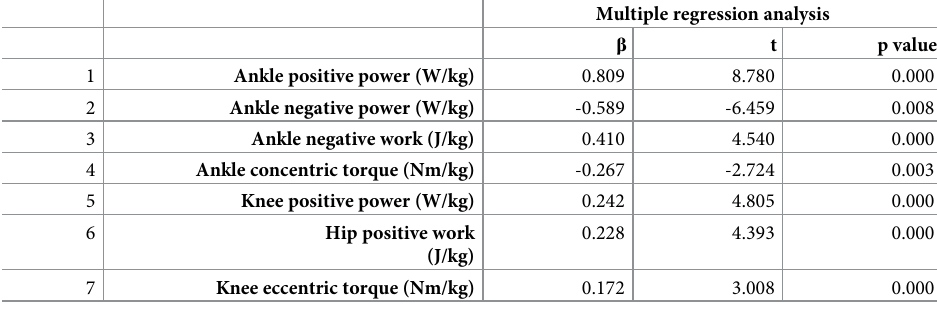
Table 2. Multiple regression predictors of the rebound jump index.